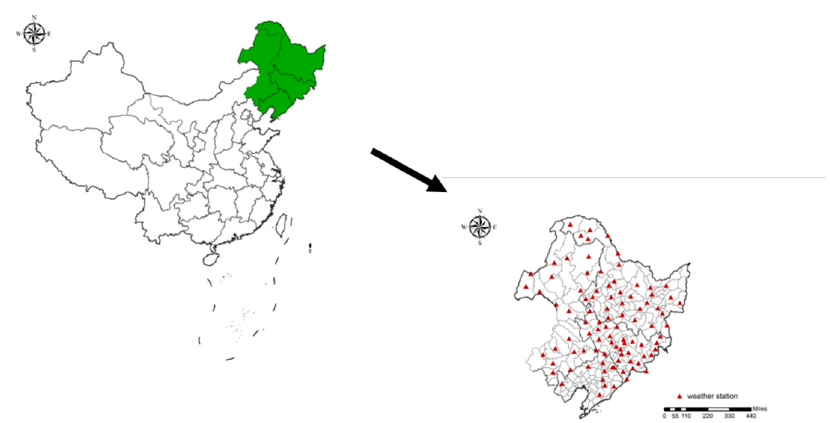
Figure 1. Distribution map of weather stations.